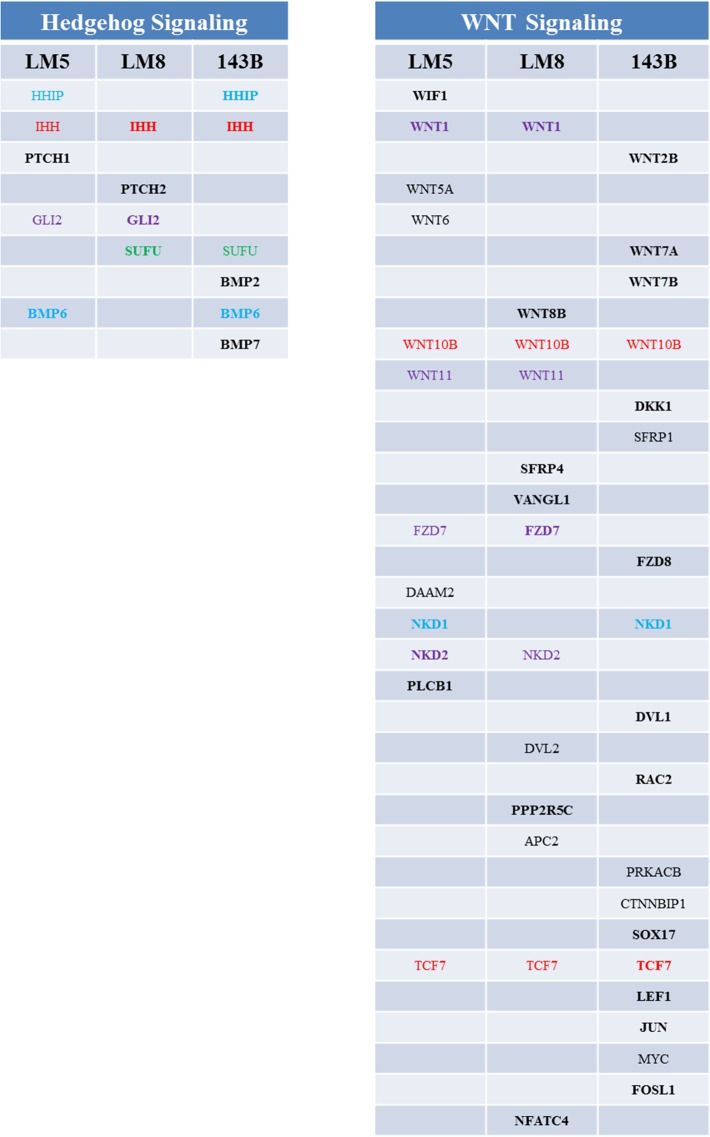
Up-regulated genes involved in hedgehog and WNT signaling in metastatic cell lines.Indicated genes are up-regulated (>2-fold; p<0.05) in at least three passage comparisons. Genes up-regulated in four passage comparisons are shown in bold. Genes marked in red are up-regulated in all three metastatic cell lines. Genes marked in purple, blue and green are shared by LM5 and LM8, LM5 and143B and LM8 and 143B, respectively.